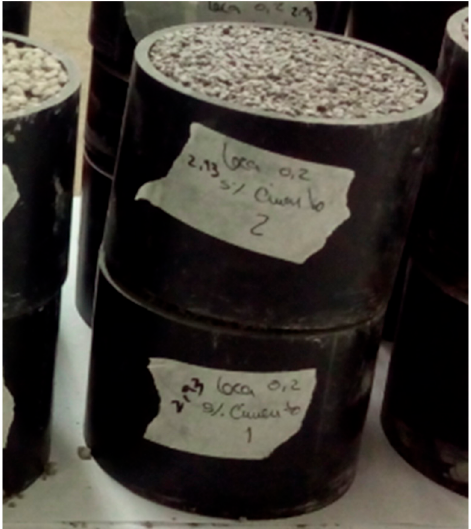
Figure 3. Porous concrete test specimens with expanded clay, prepared for impedance tube measurements. Table 1. Aggregate/Cement ratio of the porous concrete